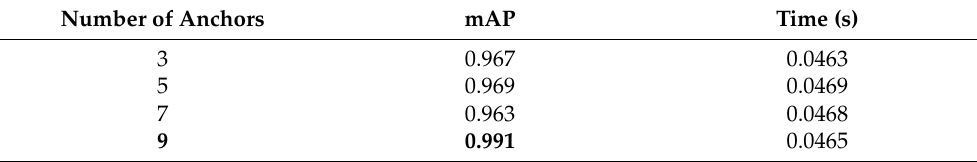
Table 4. The performance of the Faster RTLCap models with different number